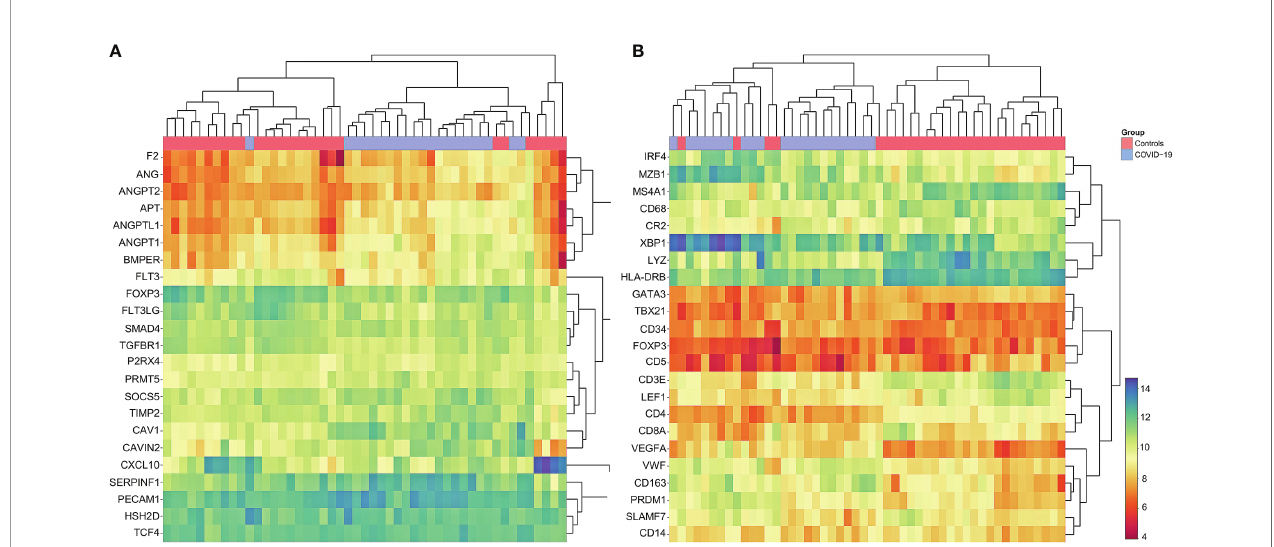
FIGURE 6 | Cluster Analysis of Gene Expression Pro fi ling in COVID-19. (A) Marked dysregulation of angiogenesis-related genes in COVID-19 compared to controls; upregulation of ANG, ANGPT2, AGT, ANGPTL1 ANGPT1, BMPER, SERPINF1 and PECAM1; note that COVID-19 cases cluster together, indicating concordance between individual cases. Individual p-values to be found in Supplementary Materials 2.5 . (B) Customized gene set enrichment and clustering analysis of related markers analyzed also by immunohistochemistry shows distinct clustering between COVID-19 and controls: downregulation of CR2 (encodes CD21), TBX21 (encodes Tbet) and LEF1; upregulation of plasmablast genes IRF4, MZB1, XBP1, PRDM1 and SLAMF7; upregulation of angiogenesis related genes (CD34 and VEGF) and of VWF; downregulation of LYZ (encoding for lysozyme) and upregulation of CD163 indicating M2 polarization of macrophages. Note that COVID-19 cases cluster together, indicating concordance between individual